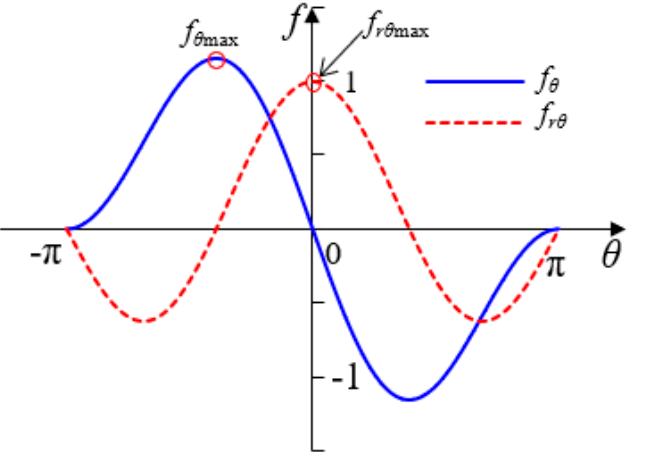
Figure 8. Distribution curve of dimensionless intensity factor for a closed crack ( f denotes dimensionless SIF).